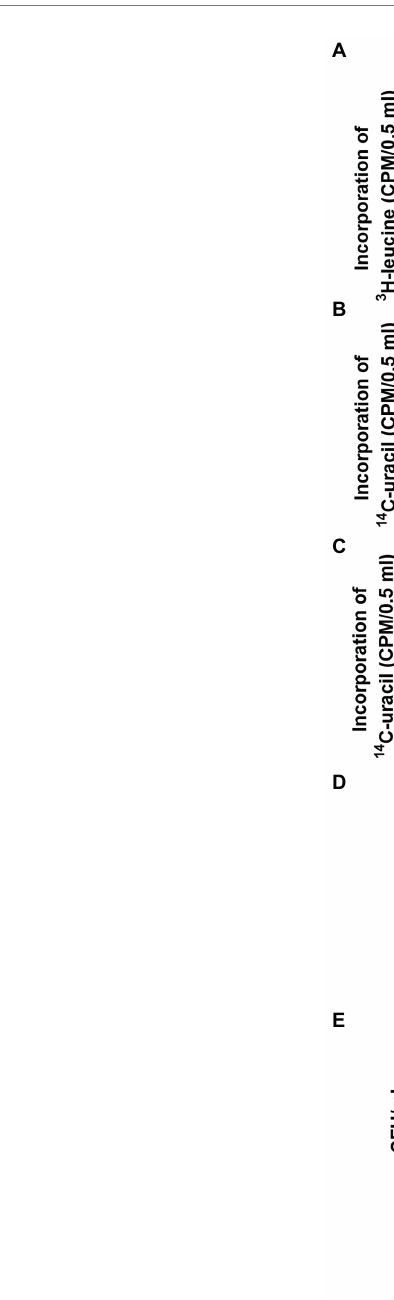
FIGURE 4 Production of unnecessary protein decreased E. coli ’s ability to recover from P starvation. Macromolecular profile of E. coli strain REP37/pIV18